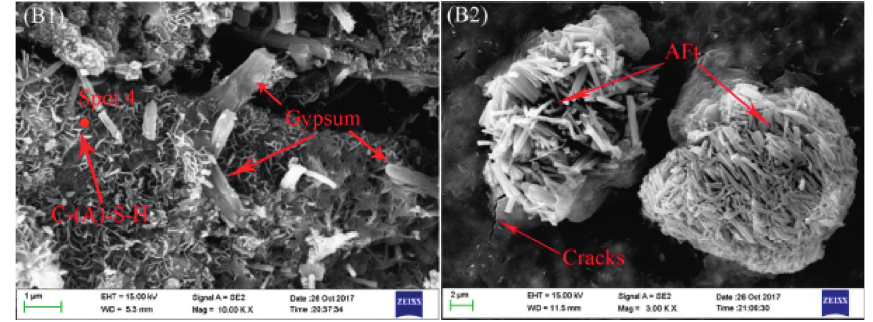
Figure 4: Structure of titanium slag and red gypsum cementitious material (from